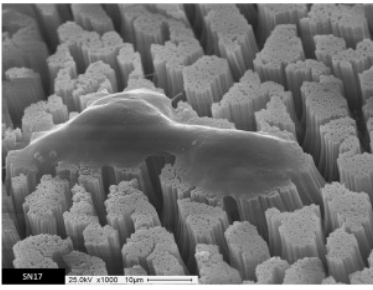
Figure 14. SEM image of an osteoblastic cell on β‐ Ketonitrile tautomeric copolymer nanowires [168],